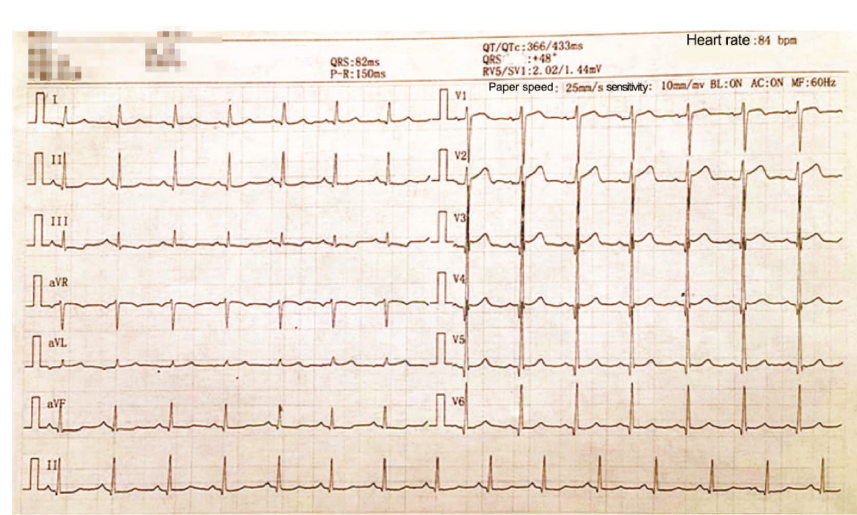
Figure 4: ECG of the older son of the